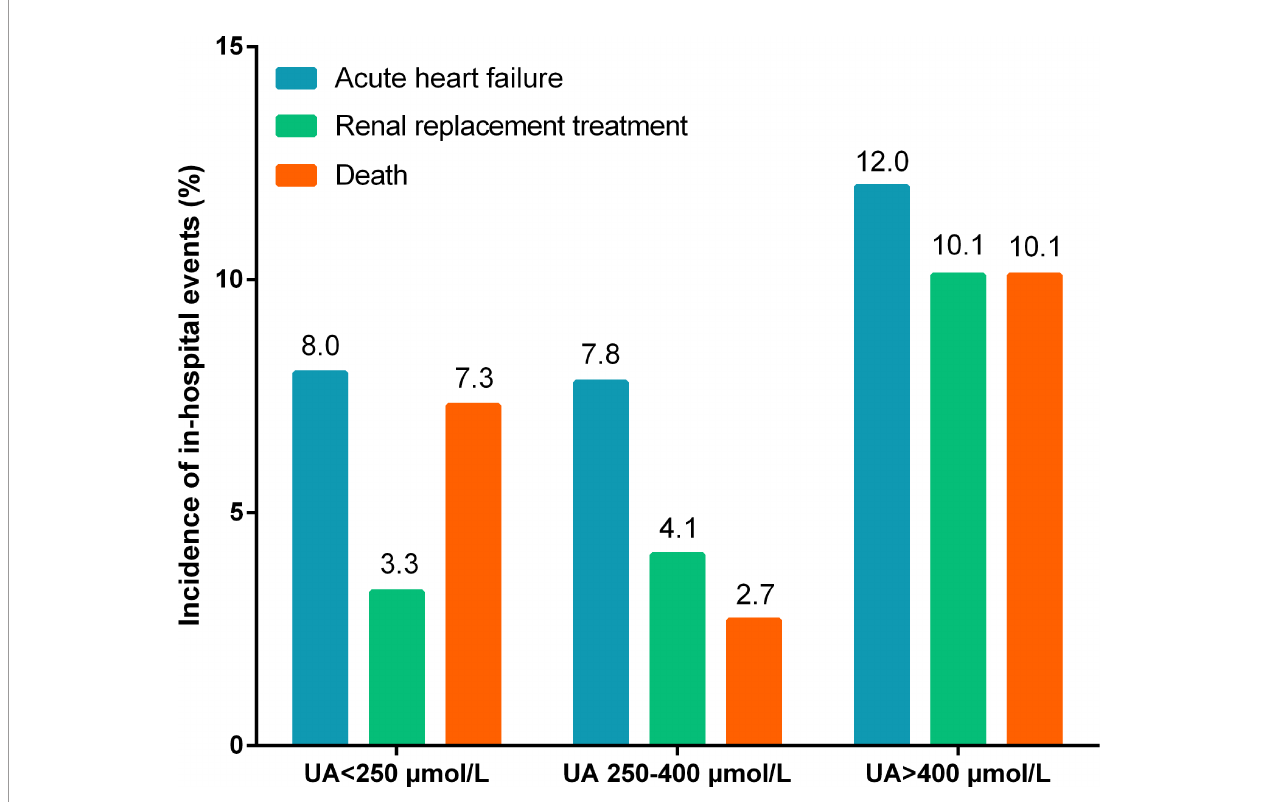
FIGURE 3 | Incidence of in-hospital events according to different uric acid levels.